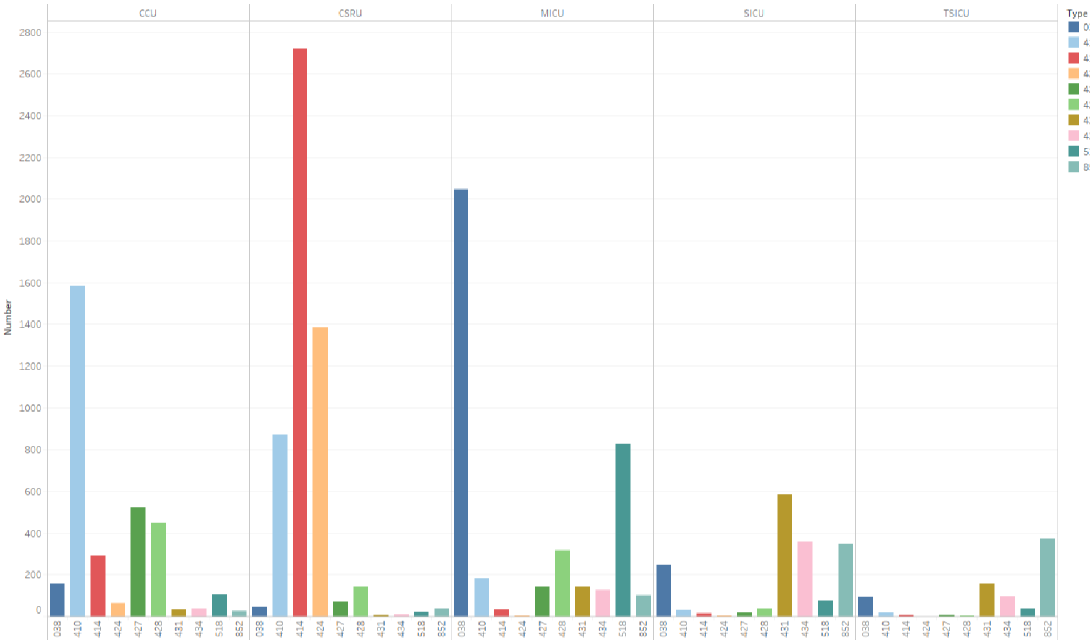
Fig 7. The distribution of ten diseases with the largest number of patients in